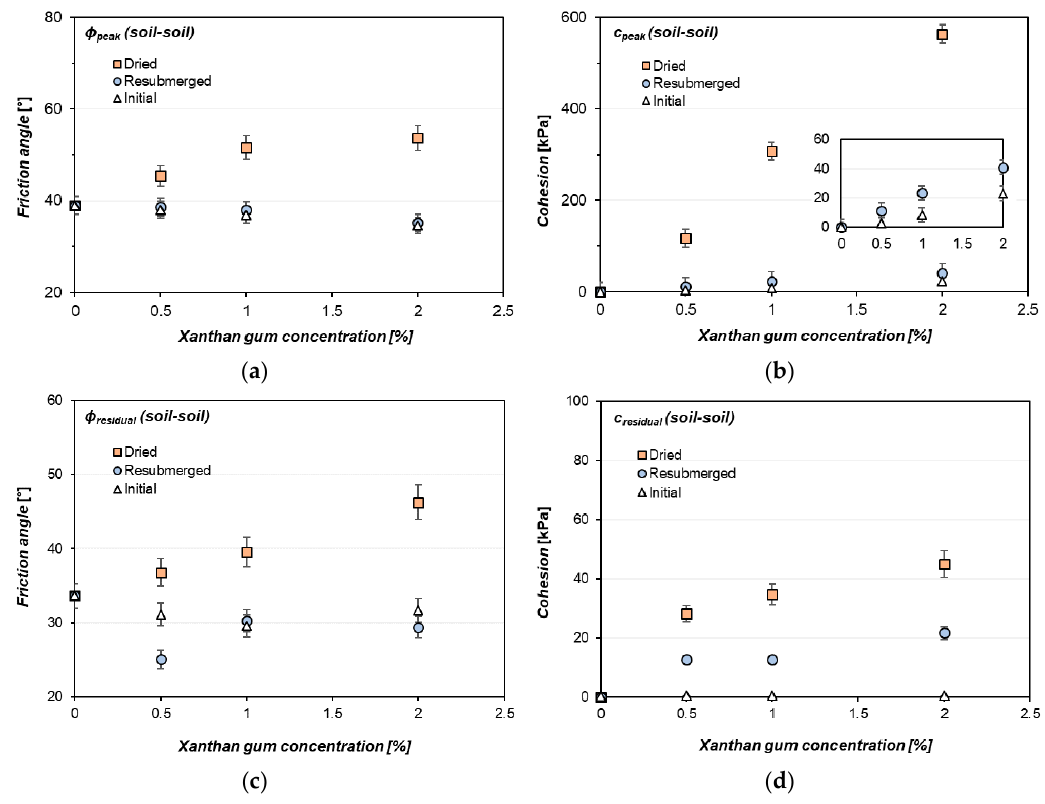
Figure 12. Internal shear parameters of xanthan gum-treated sand (soil–soil shearing): ( a ) peak internal friction angle ( ϕ peak ), ( b ) peak cohesion ( c peak ), ( c ) residual internal friction angle ( ϕ residual ), and ( d ) residual cohesion ( c residual ).